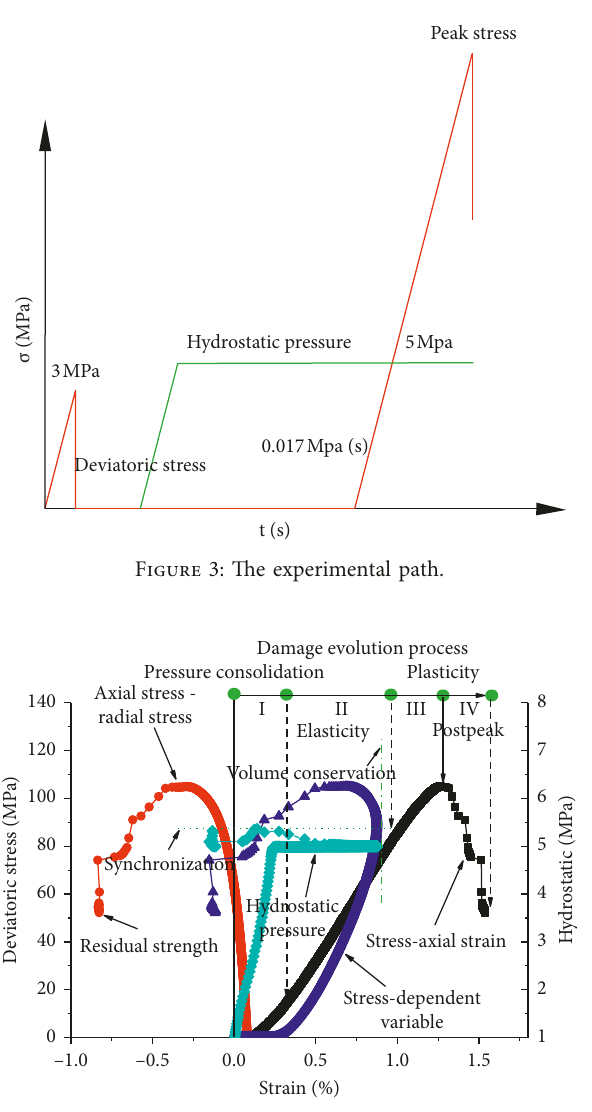
Figure 4: SZ-20 typical stress-strain damage evolution curve.